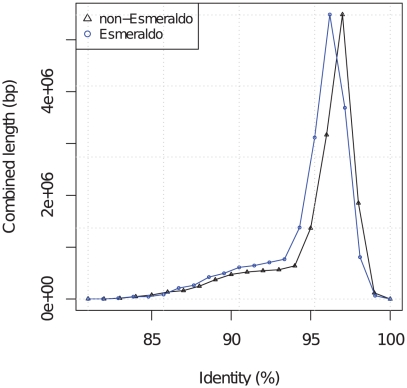
Sequence identity of Sylvio X10/1 contigs compared to non-Esmeraldo and Esmeraldo.Shows the percentage identity (horizontal axis) of the best Sylvio X10/1 versus CL Brener BLAST hit and the combined alignment length on the vertical axis. The black line (triangles) represent Sylvio X10/1 compared to non-Esmeraldo and blue lines (circles) represent Sylvio X10/1 compared to Esmeraldo. Both comparisons have a similar overall distribution of identities but Sylvio X10/1 compared to non-Esmeraldo is shifted to a slightly higher sequence identity. Sylvio X10/1 compared to non-Esmeraldo has a peak at 97% sequence identity and Sylvio X10/1 compared to Esmeraldo has a peak at 96% sequence identity.